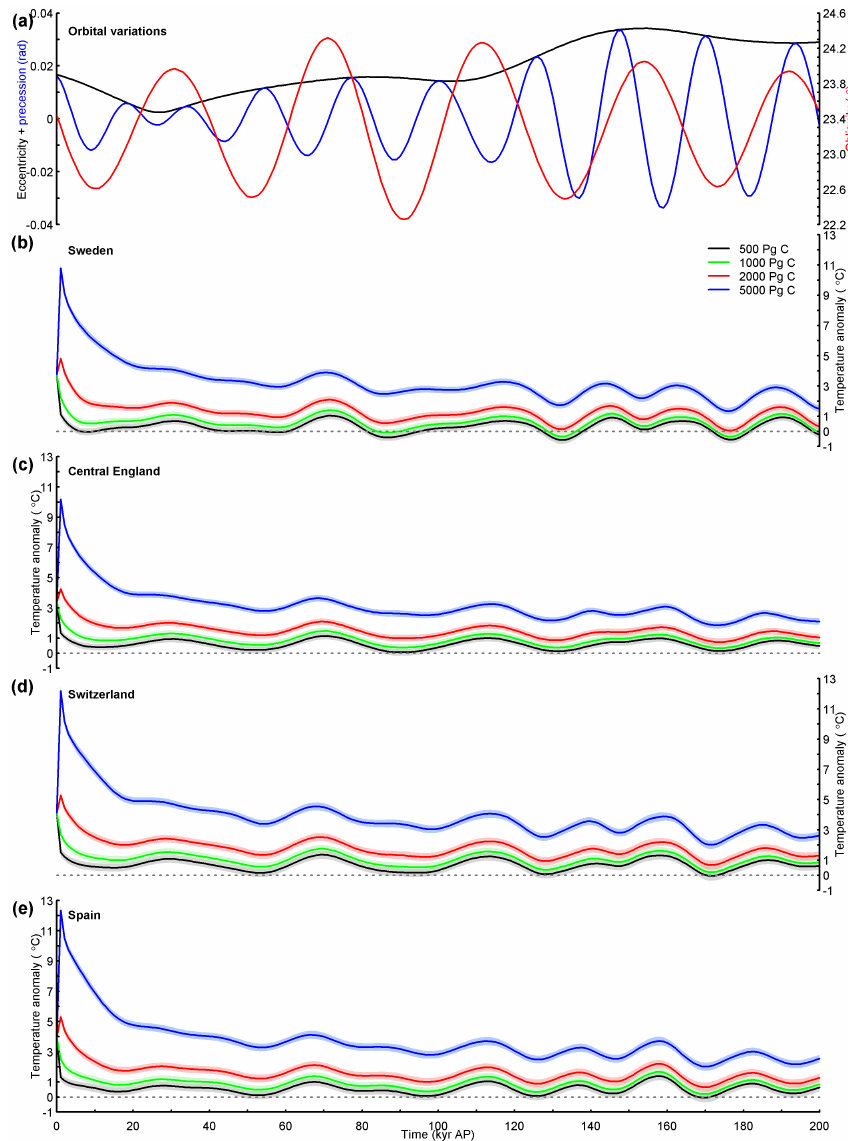
Figure 14. Emulation of SAT anomaly for the next 200kyr. (a) Time series of orbital variations (Laskar et al., 2004), showing eccentricity (black) and precession (radians, blue) on the left axis and obliquity ( ◦ , red) on the right axis. (b) – (e) Time series of emulated grid box mean annual SAT ( ◦ C), modelled every 1kyr, for four CO 2 emissions scenarios: 500PgC (black), 1000PgC (green), 2000PgC (red) and 5000PgC (blue). Modelled using the modice emulator. Error bands represent the emulated grid box posterior variance (1SD). Four sites are presented, representing grid boxes in Sweden, central England, Switzerland and Spain. SAT is shown as an anomaly compared with the pre-industrial control